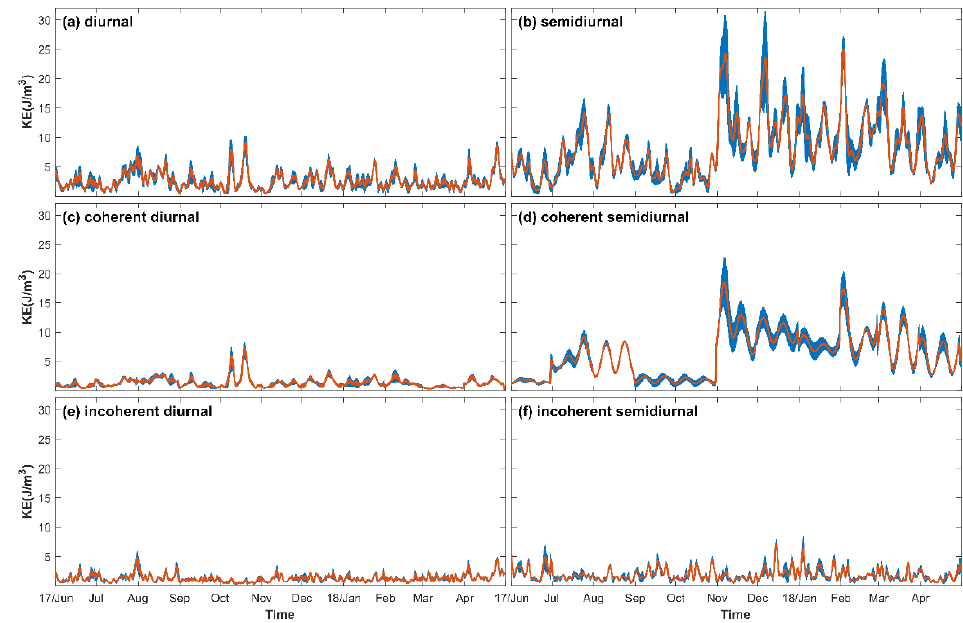
Figure 4. Evolution of the depth-mean kinetic energy density of the ( a ) diurnal, ( b ) semidiurnal, ( c ) coherent diurnal, ( d ) coherent semidiurnal, ( e ) incoherent diurnal, and ( f ) incoherent semidiurnal ITs. The blue lines are the hourly kinetic energy density, and the orange lines are the 25-h averaged depth-mean kinetic energy density.